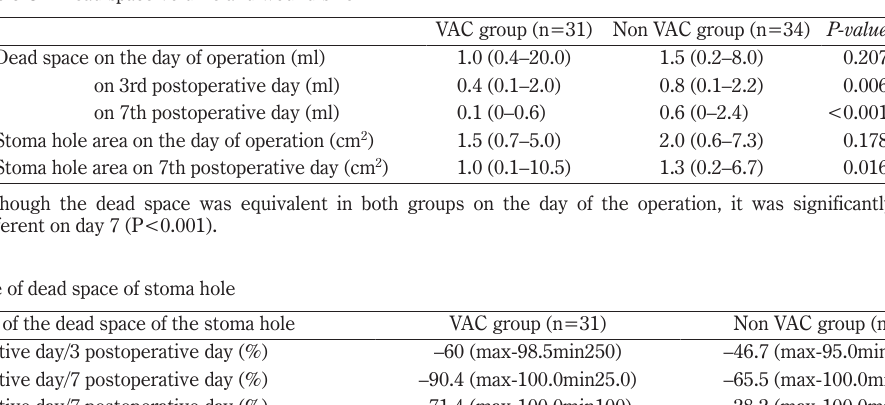
Table 3 Dead space volume and wound size